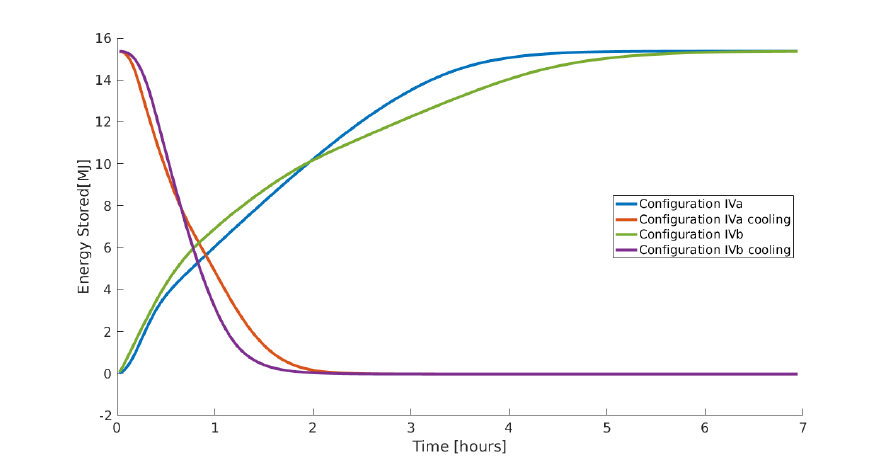
Figure 11. Energy stored in PCM particles.